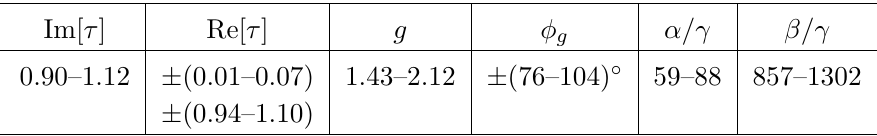
Figure 5 . The prediction of (cid:14) CP versus sin 2 (cid:18) 23 for IH in model III. The vertical red lines rep- resent the upper and lower bounds of the ex- perimental data with 3 (cid:27) .